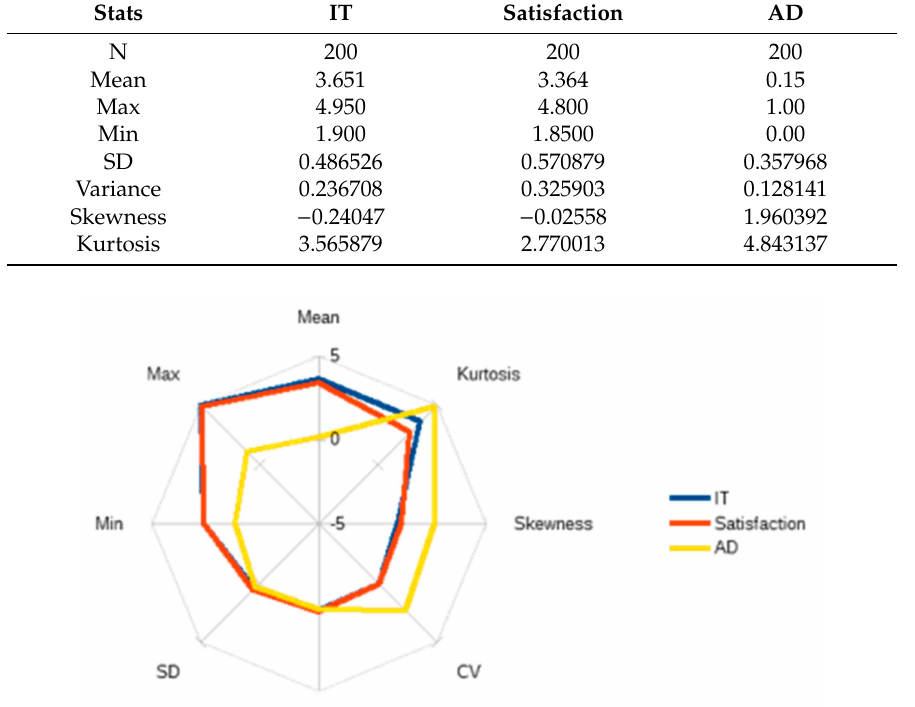
Table 3. Summary statistics.